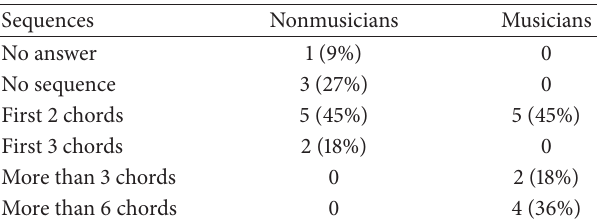
Table 5: Table of chord sequences identified by the subjects during the harmonization task.